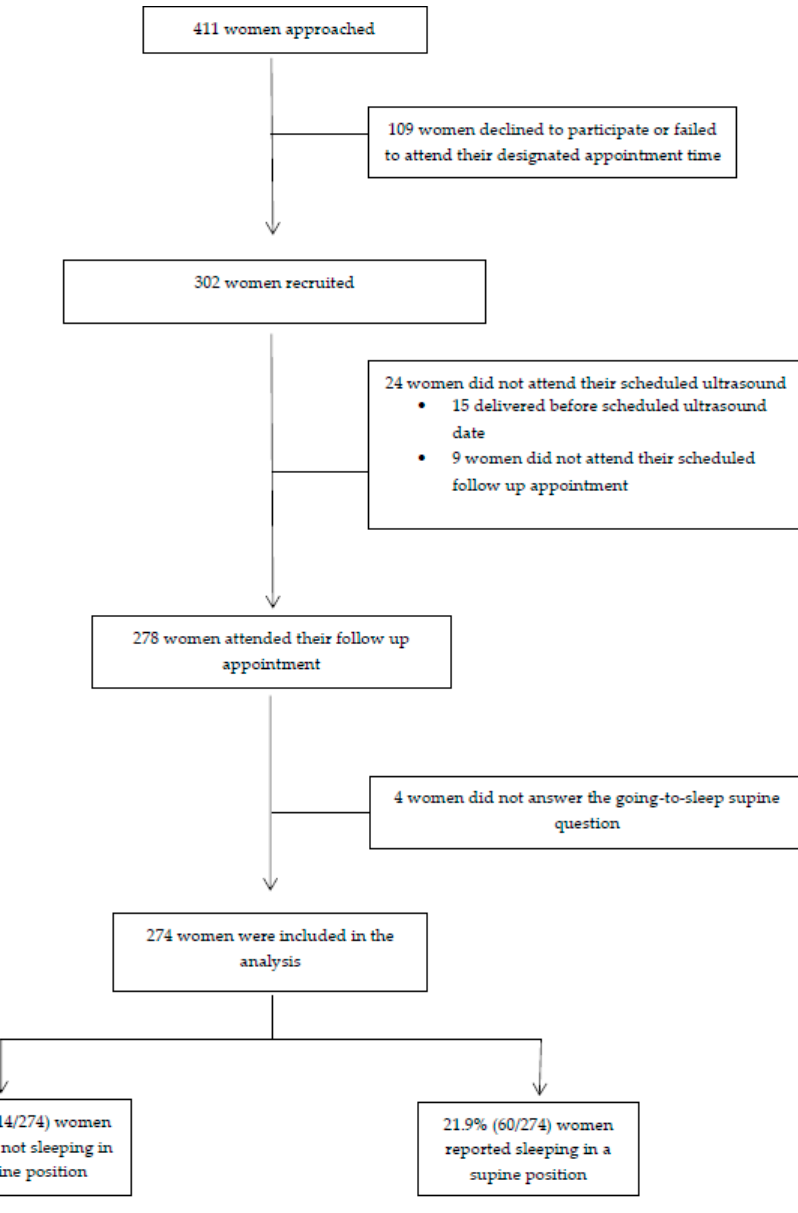
Figure 1. Recruitment flowchart.